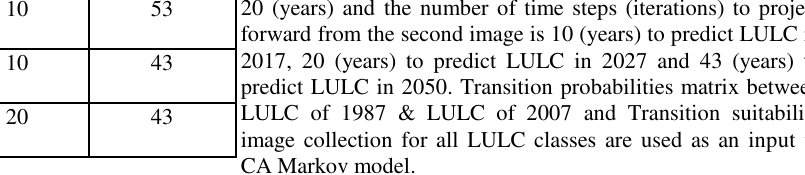
Table 3. Prediction years, data used, time interval (between the first and second images) and different time steps (iterations)